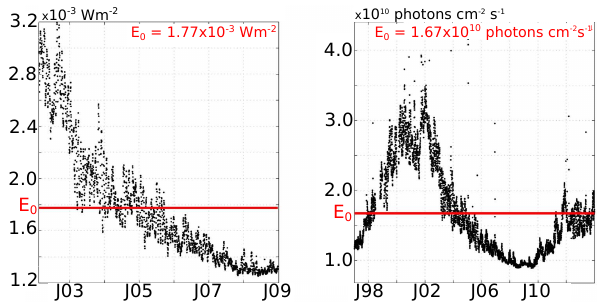
Figure 1. Integrated intensity flux of the daily averages by TIMED/SEE (25–92nm, left) and SOHO/SEM (26–34nm, right). Data from the latter mission will be used in Sect. 3.2.